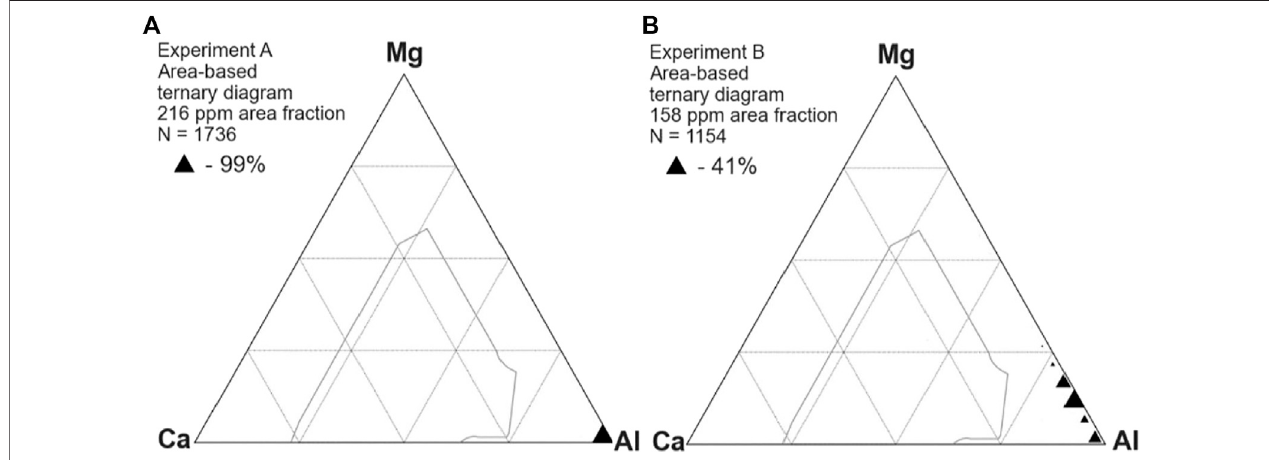
FIGURE 2 | Composition of inclusions before Ca treatment, showing alumina in experiment A (A) and alumina-spinel inclusions in experiment B (B) .